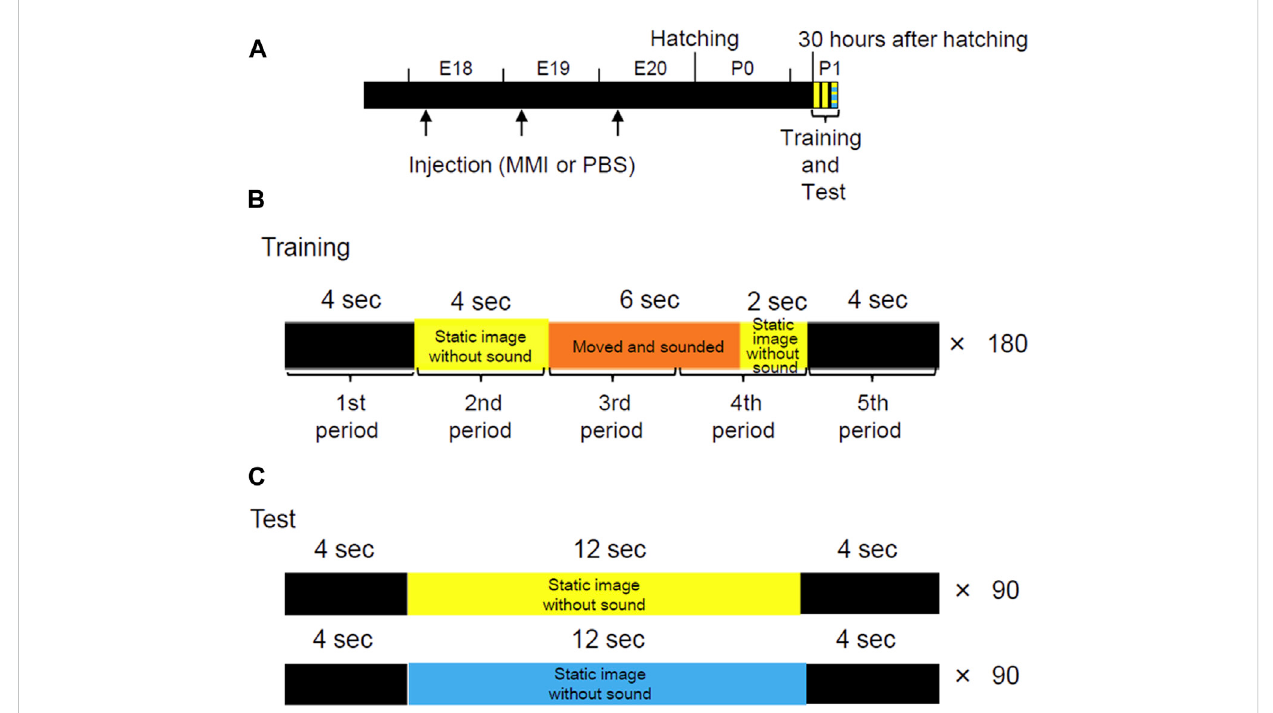
FIGURE 1 Experimental procedures to observe the effects on imprinting of thyroid hormone synthesis decrease in the pre-hatch period. (A) Schematic representation of the experimental procedure. The incubated eggs were injected with methimazole (MMI) or phosphate-buffered saline (PBS) once per day from embryonic day (E) 18 to E20. Imprinting training and tests were conducted 30 h after hatching. These methods are similar to those in the study performed by Aoki et al., 2022a. (B) In one session of training, a movie, 20 s long, was repeatedly played on the monitor 180 times for 1 h. In the training movie, a yellow imprinting object appeared for 12 s. The object was static for the fi rst 4 s, then repeatedly turned clockwise and anti-clockwise with arti fi cialsounds for 6 s. After the object stopped moving, itremained static again for thelast 2 s. A trialof 20 s was divided into fi ve periods (4 seach) toanalyzetheperformanceofthechicksduringtraining. (C) Inthepreferencetest,twotypesofmovies(20 seach)wereplayedpseudo-randomlyfor1 h. In one movie, the yellow imprinting object appeared for 12 s and remained static without making a sound. In another movie, a blue control object appeared for 12 s and remained static without